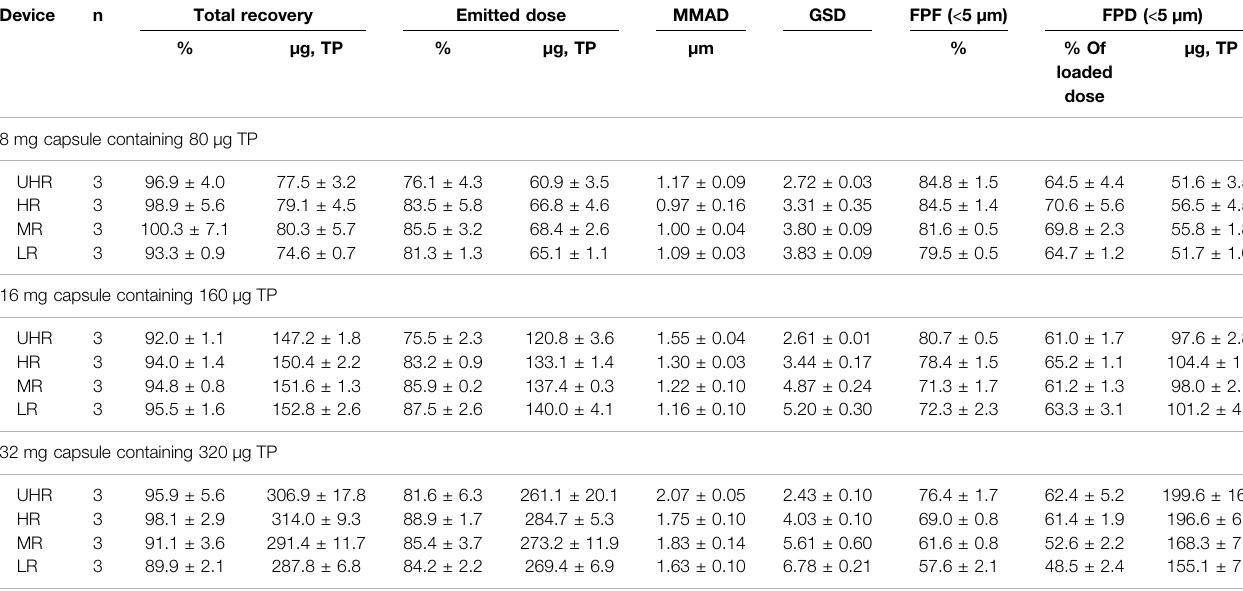
TABLE 1 | TPIP aerosol particle size distribution characteristics as a function of device resistance.